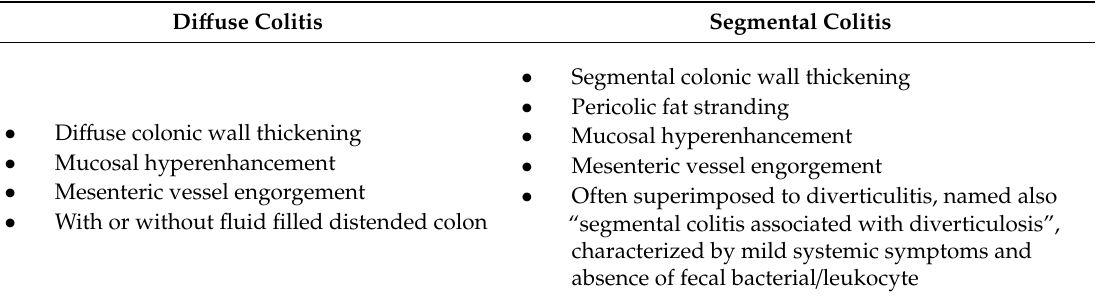
Table 2. Two computed tomography (CT) patterns of immune-mediated